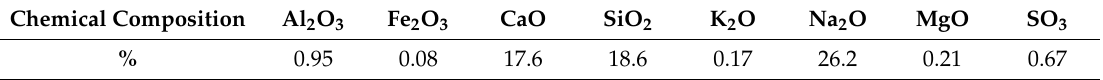
Table 1. Chemical composition (wt.%) of the inorganic additive Krystaline Add1.